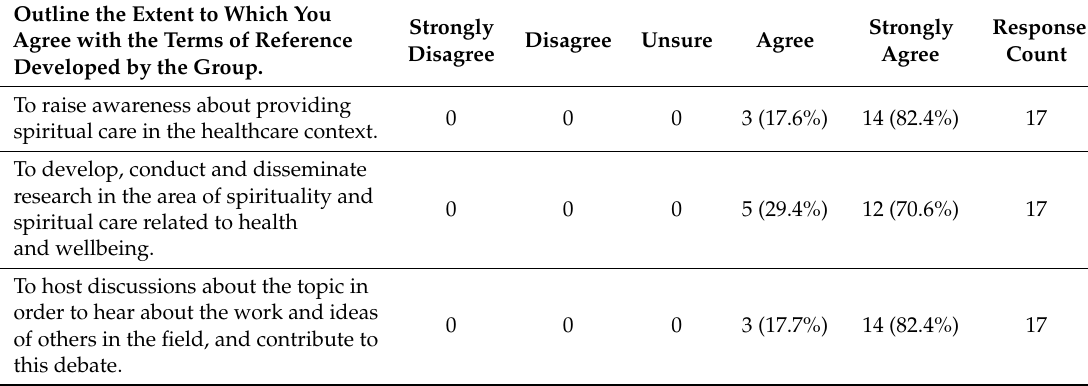
Table 2. The extent to which the SIG members agree with the group’s terms of reference.